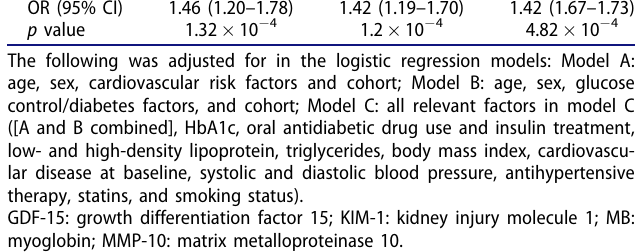
Table 3. Cox regression models for the association between discovered and replicated circulating proteins and time to major adverse cardiovascular events.